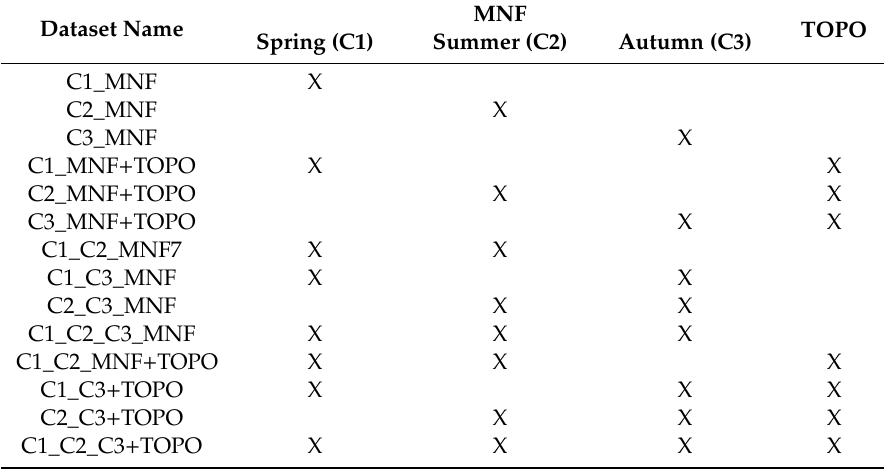
Table 2. Datasets subjected to random forest (C1, C2, C3—campaign number, MNF—minimum noise fraction, TOPO—topographic indices).